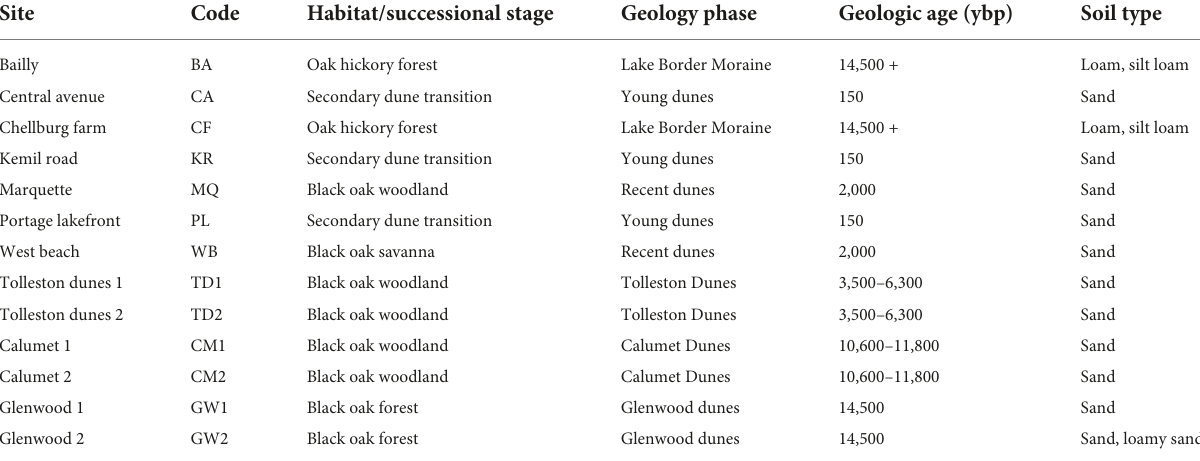
TABLE 1 Field sites, their habitats, geological phase, approximate system age, soil